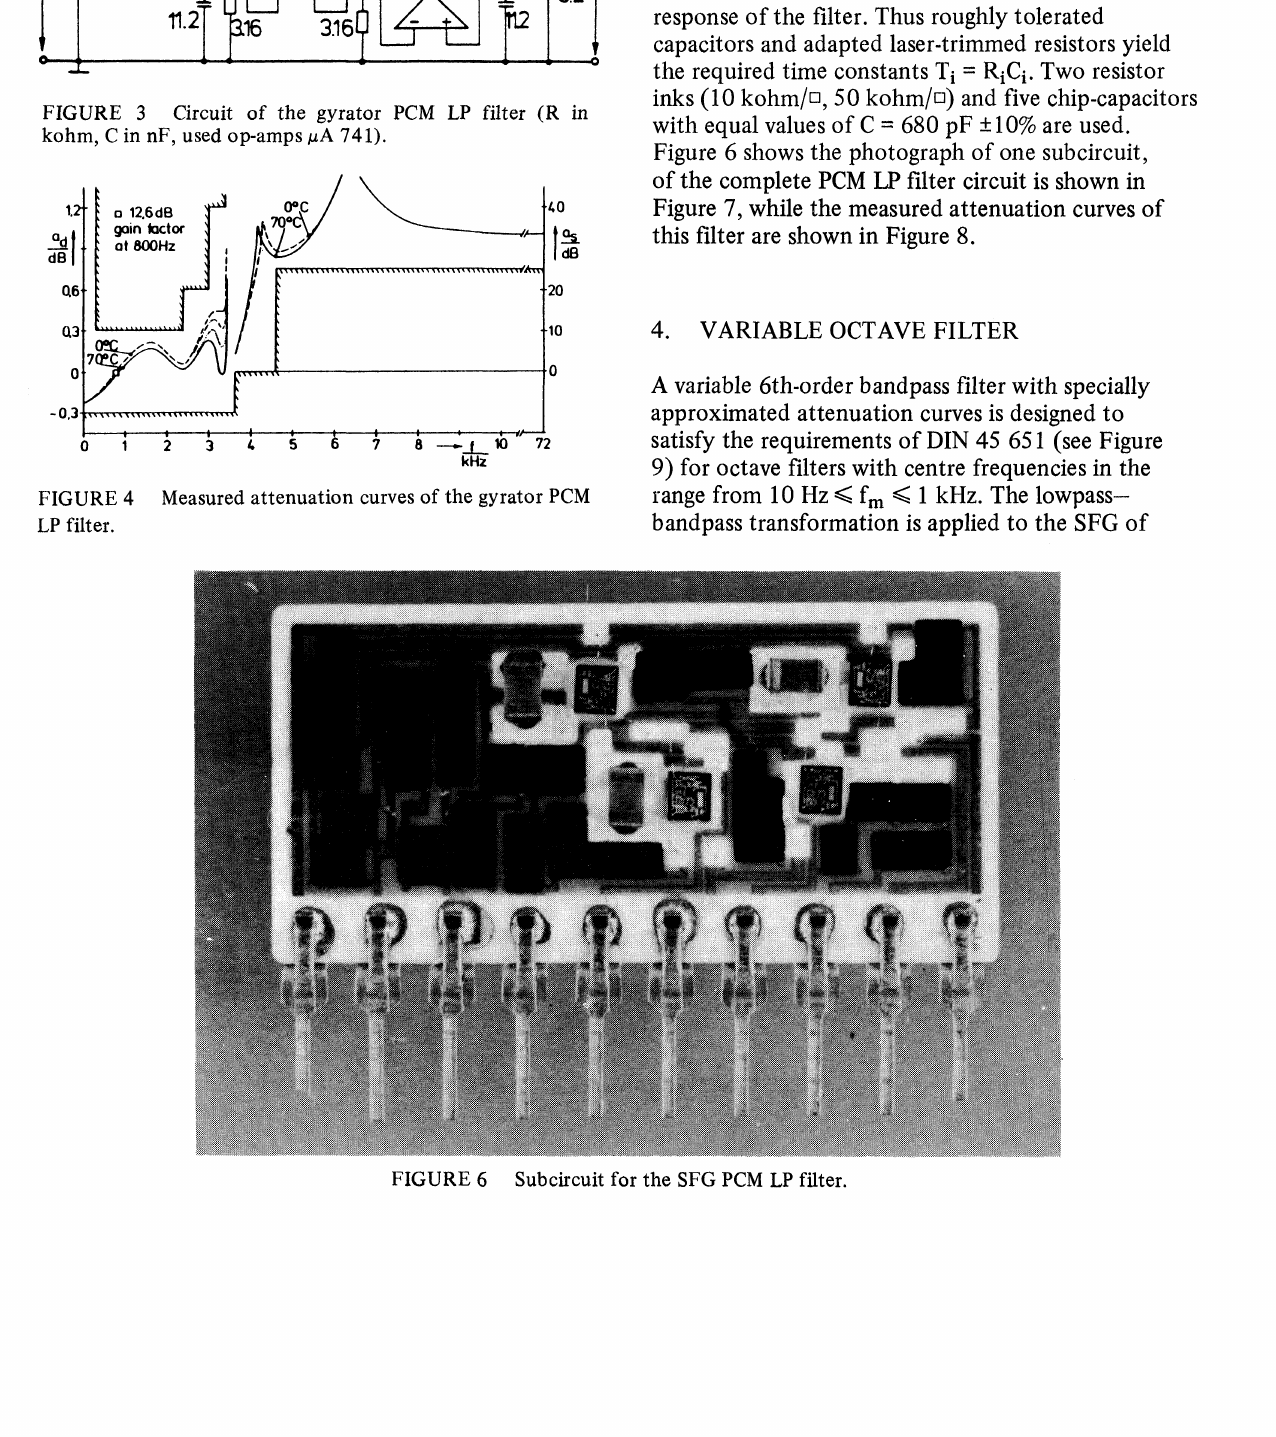
Circuit of the gyrator PCM LP filter (R in kohm, C in nF, used op-amps uA 741).